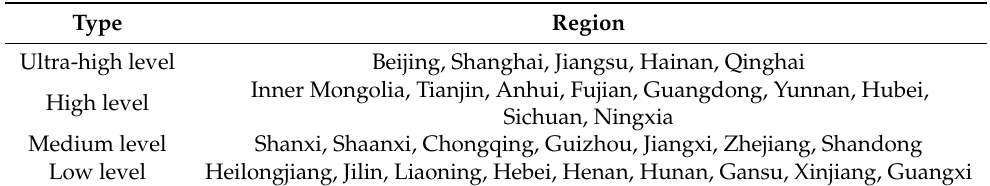
Table 4. Spatial clustering effect of environmental performance by natural interruption point grad- ing